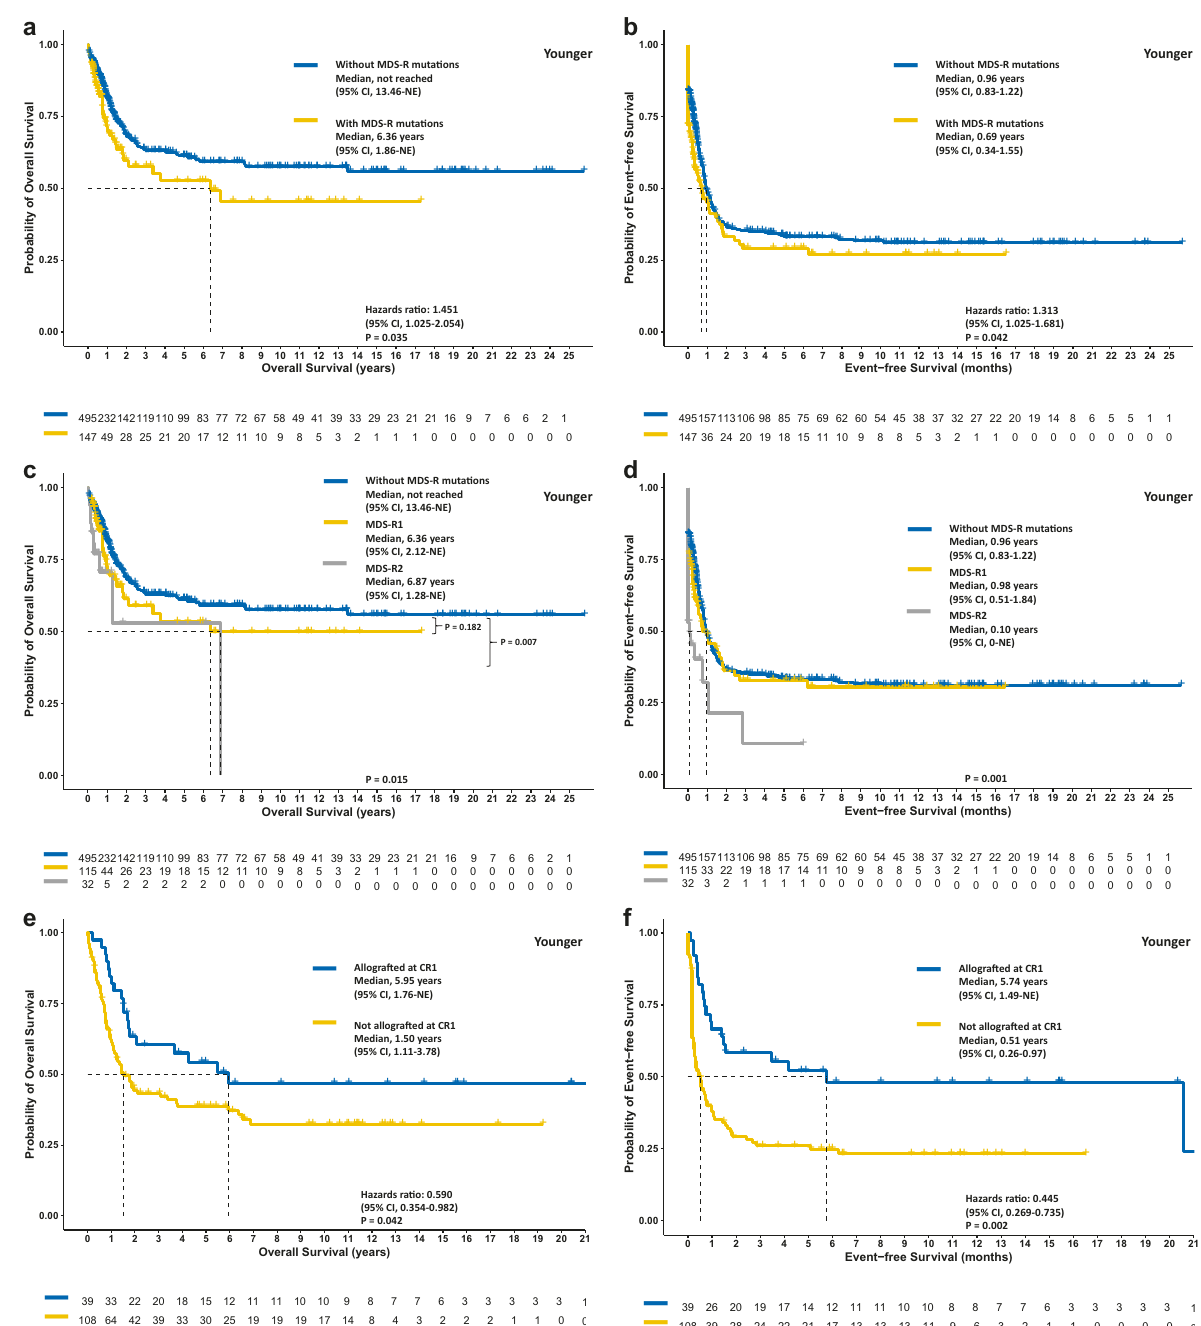
Fig. 4 The Kaplan ‒ Meier survival curves for the younger patient cohort. OS ( a ) and EFS ( b ) of patients strati fi ed by the status of MDS-R mutations, the MDS-R mutation burdens ( c and d , respectively), and treatment with or without allogeneic transplantation at fi rst remission ( e and f , respectively). Patients receiving allogeneic transplantation at fi rst remission experienced longer OS ( e ) and EFS ( f ). MDS-R1, with one MDS-R mutation; MDS-R2, with 2 or more MDS-R